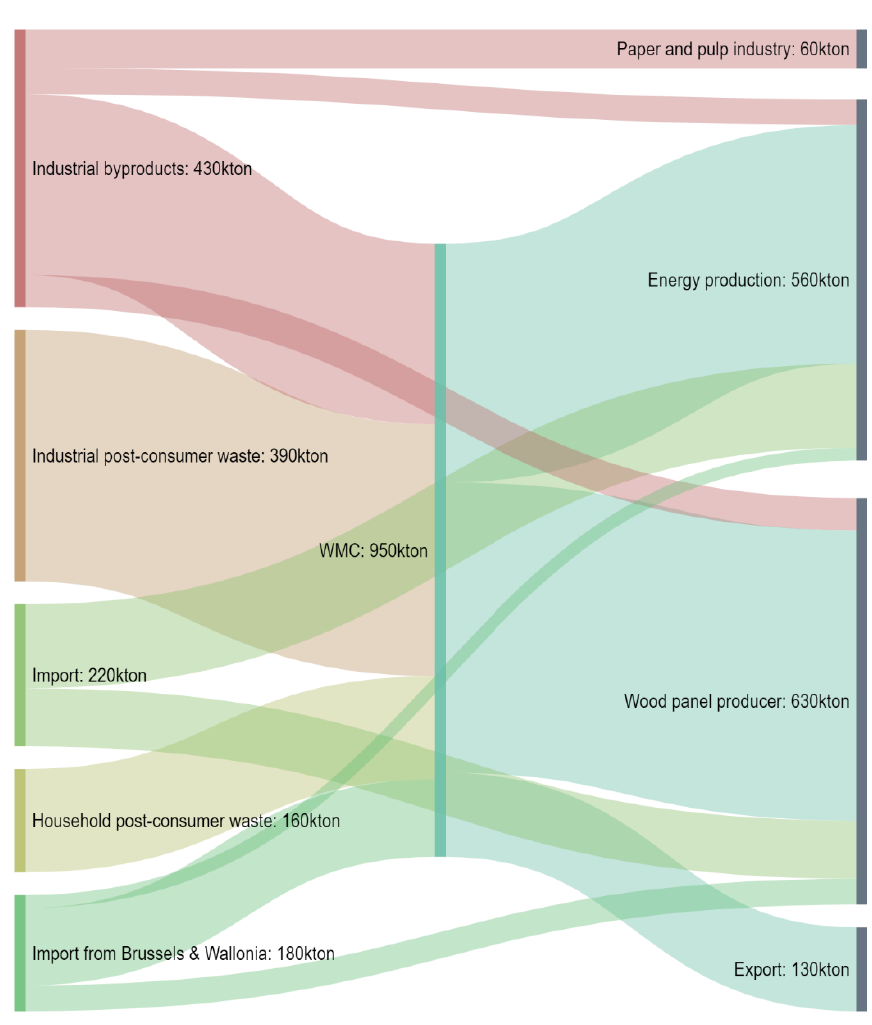
Figure 6. Sankey diagram of the waste wood flows in Flanders in 2014 (executed by Kranti Navare, 2019) (WMC = waste management centre).